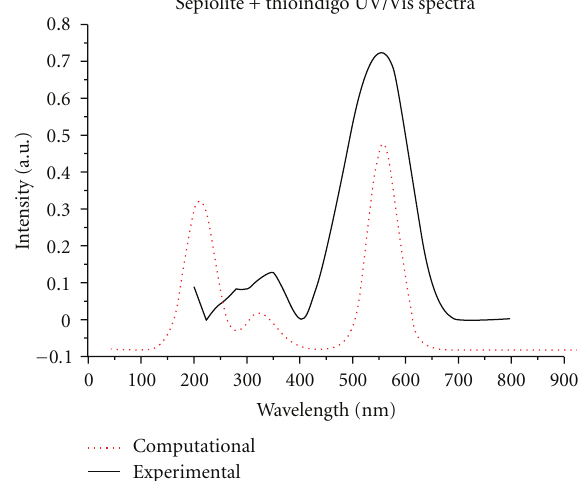
Figure 7: Comparison of computational and experimental UV/Vis spectrum of the thioindigo/sepiolite complex.